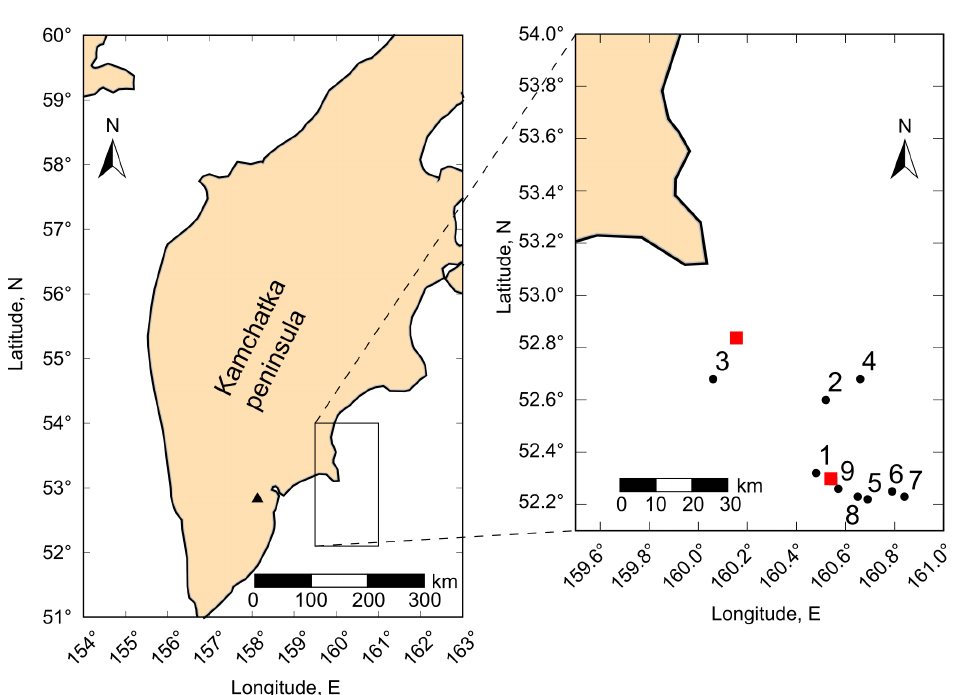
Figure 3. Map of Kamchatka peninsula with location of earthquake epicenters presented in the CMT catalog and occurred during the period from 1 January 1976 to 30 June 2022 (black circles) in the area under the study and location of simulated earthquake epicenters (red squares). Location of earthquake epicenters are shown in scaled part of map. The black triangle on the map indicates the location of the Karymshina observation